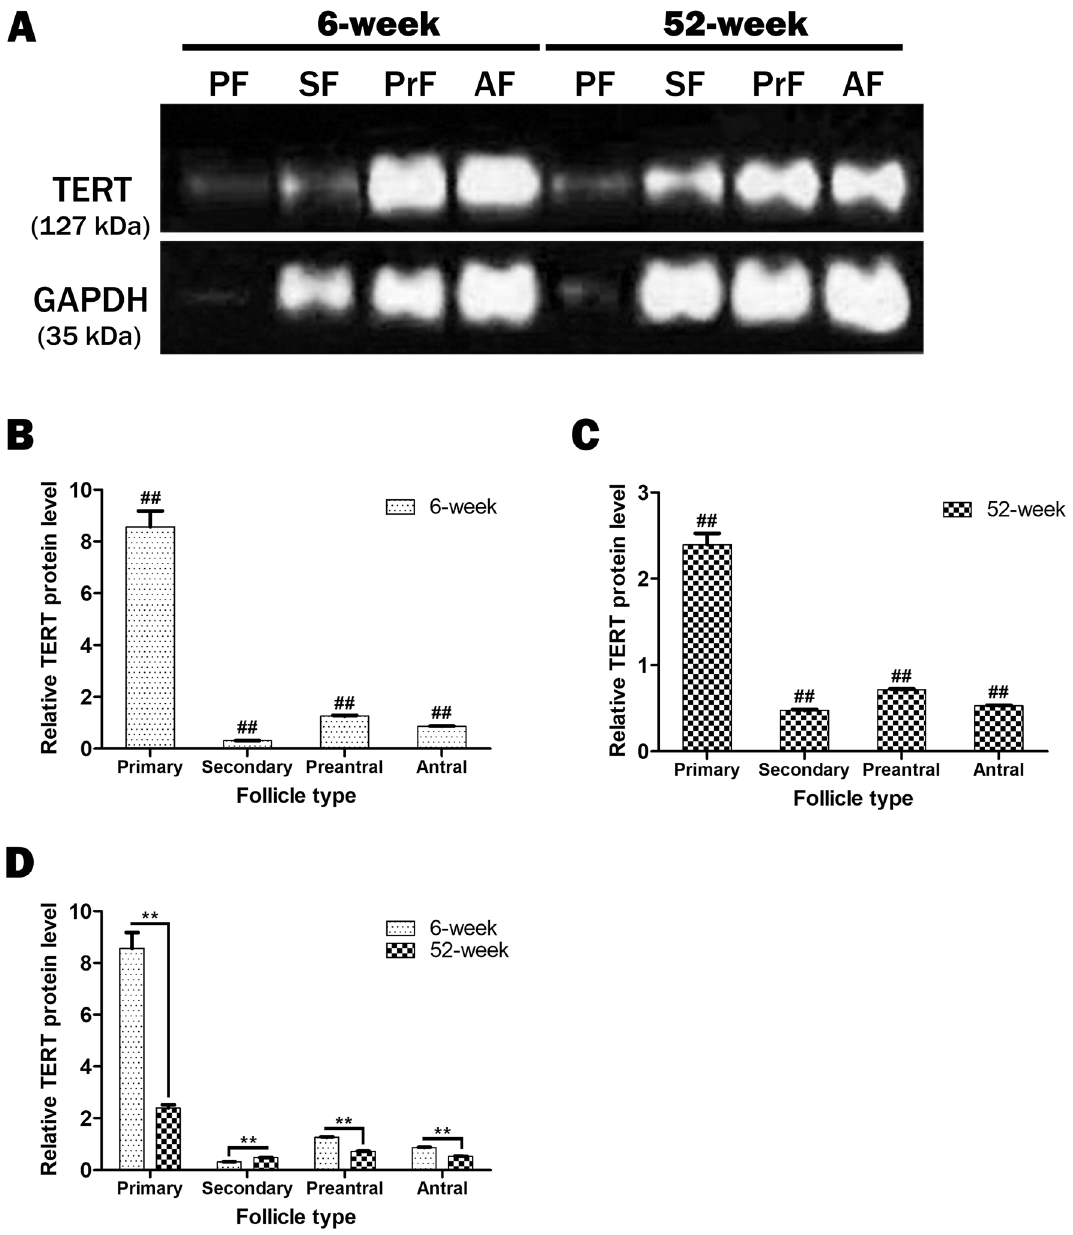
Figure 3. The TERT protein levels in the ovarian follicles from primary to antral stages, obtained from adult (6-week-old) and aged (52-week-old) groups. In this analysis, we used primary (n = 60 and 46), secondary (n = 77 and 58), preantral (n = 59 and 64), and antral (n = 56 and 38) follicles from 14 adult and 9 aged mice, respectively. ( A ) Western blotting (WB) results showing bands corresponding to the TERT and glyceraldehyde-3-phosphate dehydrogenase (GAPDH) proteins in the isolated follicles. GAPDH (in the molecular weight of 35 kDa) was used as an internal loading control. All the follicles either from adult or aged groups possessed the TERT protein (in the molecular weight of 127 kDa) at different levels. The bands produced via WB were analyzed using the ImageJ software program version 2.0 (bundled with 64-bit Java 1.8.0_172; NIH, Bethesda, Maryland, USA, URL link: https:// imagej. nih. gov/ ij/ downl oad), and the results were presented as a column chart. PF primary follicles, SF secondary follicles, PreF preantral follicles, AF antral follicles. ( B ) The relative TERT protein levels in the follicles from the adult group. The highest and lowest TERT protein levels were observed in the primary ( P < 0.01) and secondary ( P < 0.01) follicles, respectively. It should be noted that there were statistical significances among all follicle types ( ## P < 0.01). ( C ) The relative TERT protein levels in the follicles from the aged group. It progressively decreased from primary to antral follicles except for the secondary follicles, where a marked reduction was observed ( P < 0.01). It is worth noting that there were statistical significances among all follicle types ( ## P < 0.01). ( D ) The comparison of relative TERT protein levels in the follicles between adult and aged groups. In the aged group, we detected lower TERT protein levels in the primary, preantral, and antral follicles ( P < 0.01), but higher levels in the secondary follicles ( P < 0.01) when compared to those of their adult counterparts. There were statistical significances among all follicle types (** P < 0.01). Here, the statistical significances in B and C were evaluated using one-way ANOVA test and the Student–Newman–Keuls post hoc test (denoted by ## ); the student’s t -test (denoted by **) was used in D. The data obtained are presented as means ± standard deviations (SDs; arising from two technical